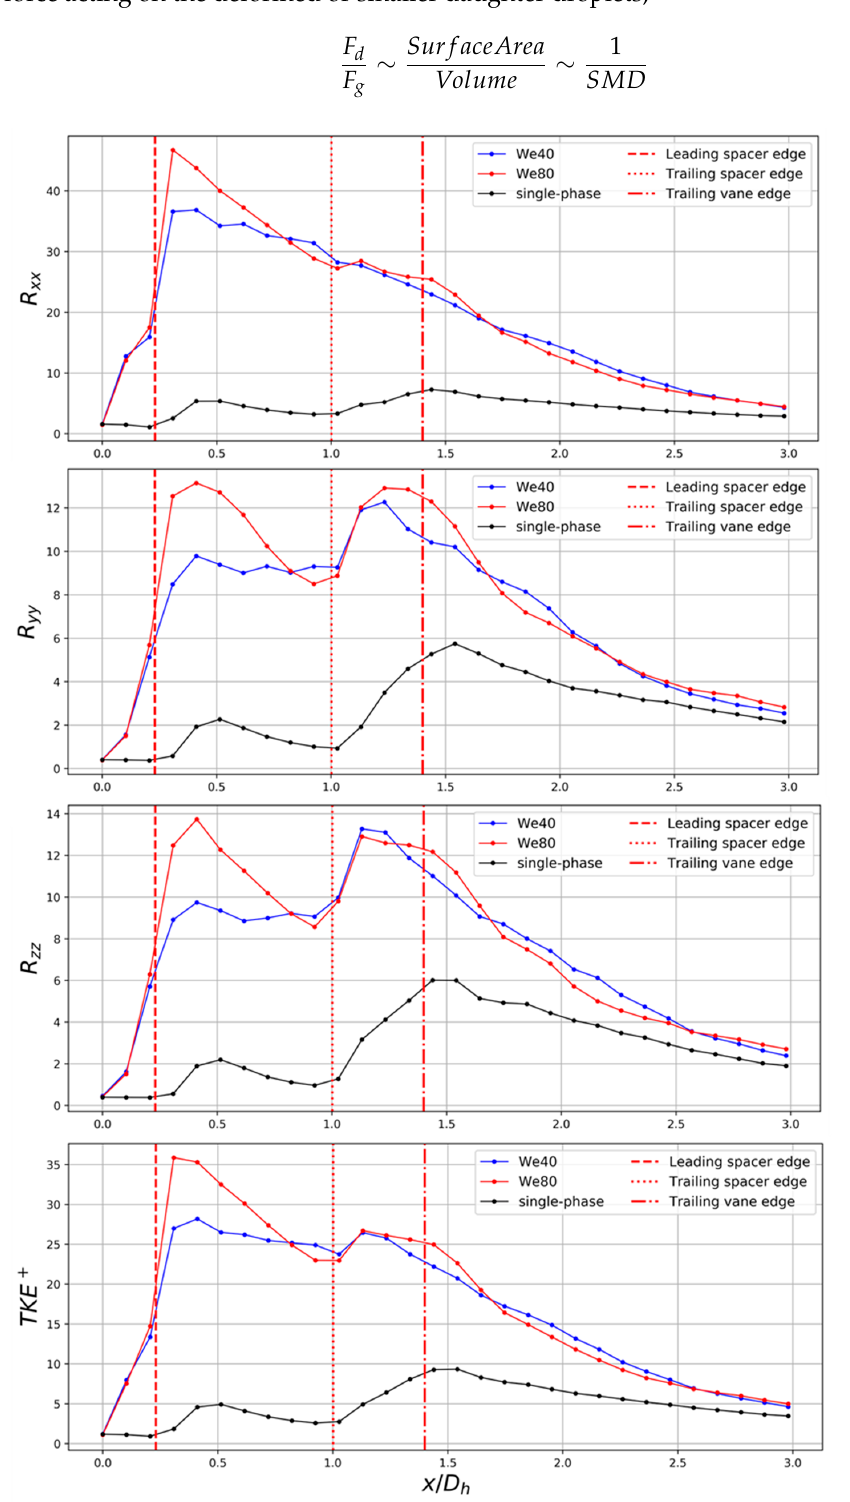
Figure 15. Axial evolution of plane averaged normalized Reynolds stress components and turbulent kinetic energy profile for the single-phase, We40 and We80 cases.